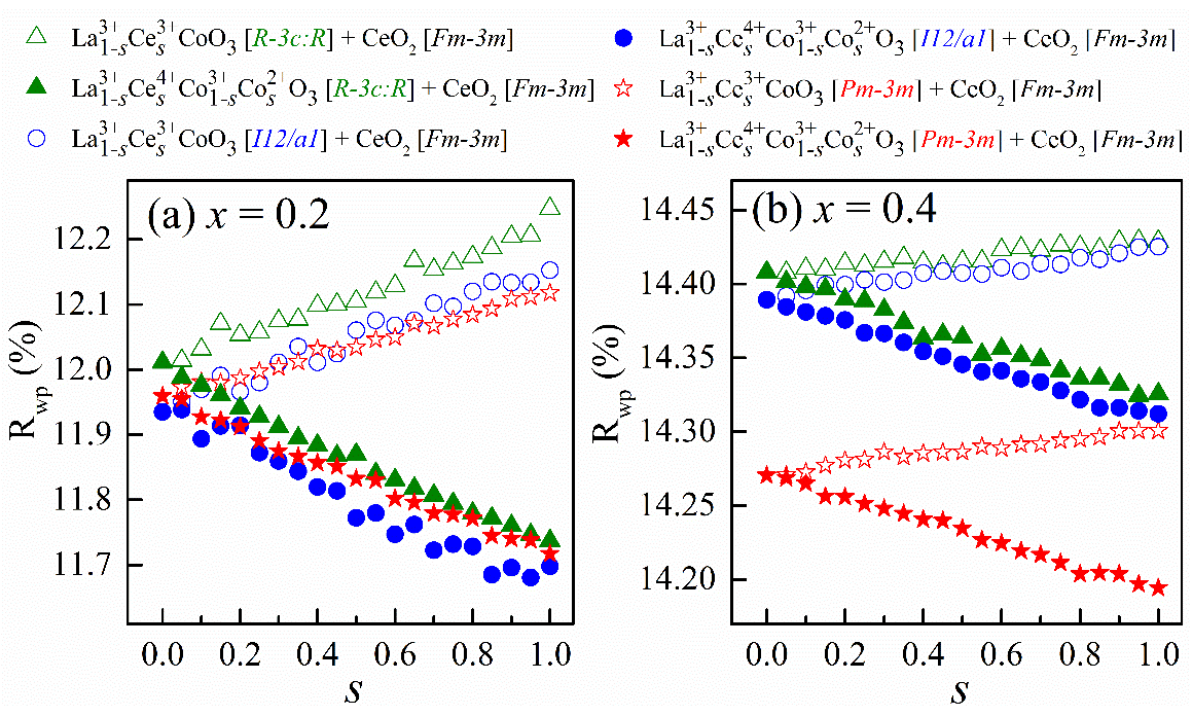
Figure 1. Weighted profile R -factor as a function of s , the fraction of cerium dopants in the main phase of La 1 − x Ce x CoO 3 with ( a ) x = 0.2 and ( b ) x = 0.4. In these Rietveld fits, six models consider three different space-groups of the main phase and two forms of dopants. The three space groups are R-3c: R (rhombohedral), I12/a1 (monoclinic), and Pm-3m (cubic). The two cases of cerium dopants are Ce 3+ and Ce 4+ /Co 2+ . The secondary phase, CeO 2 , has a face-centered cubic space group of Fm-3m .